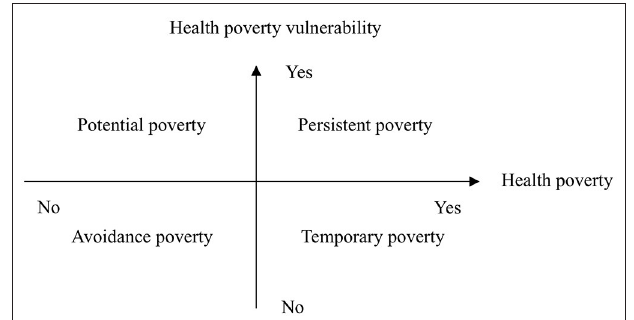
FIGURE 1 | Dichotomies of health poverty and vulnerability.